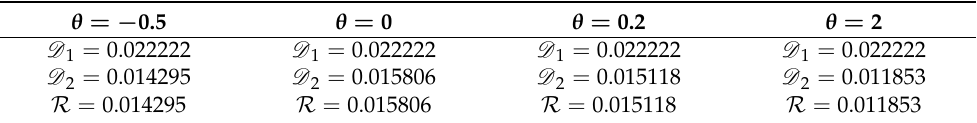
Table 2. Radii of convergence balls for Example 2.